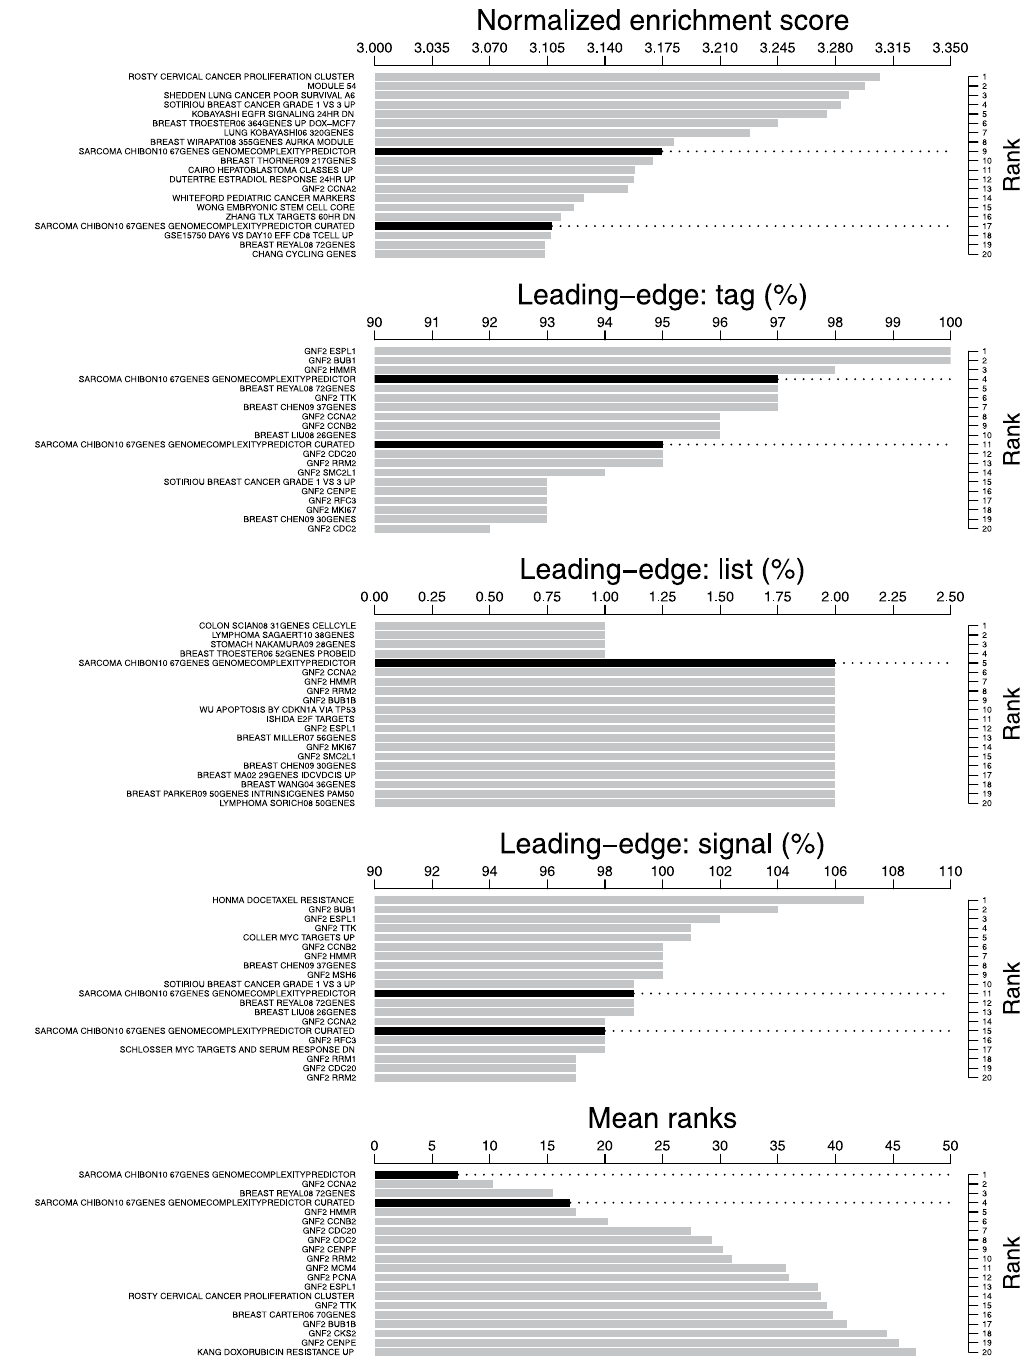
Figure 2. Pan-cancer overview of the top 20 signatures by several metrics (from top to bottom): normalized enrichment score, tag (sensitivity), list (false-negative rate), signal (enrichment strength) and the mean ranks of the previous metrics. Histograms are sorted to display best to worst ranks from top to bottom, respectively. CINSARC signatures are highlighted in